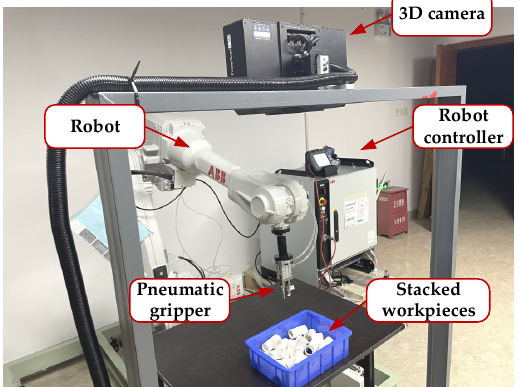
Figure 10. The experimental setup. A binocular structured light 3D camera is used to obtain high- quality point clouds of stacked workpieces. The ABB IRB 2600-20 robot with pneumatic grippers at the end is shown in the figure. I/O programming can control the clamping state of the pneumatic gripper to grasp workpieces. The robot is controlled by the controller.